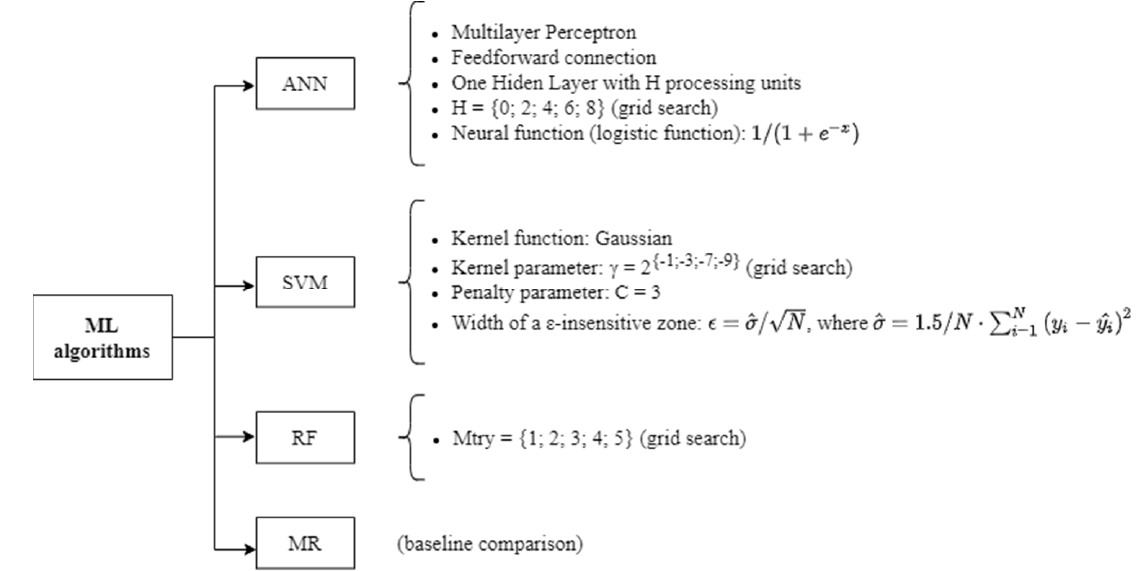
Figure 1. Definitions and hyperparameter adopted for each ML algorithm.